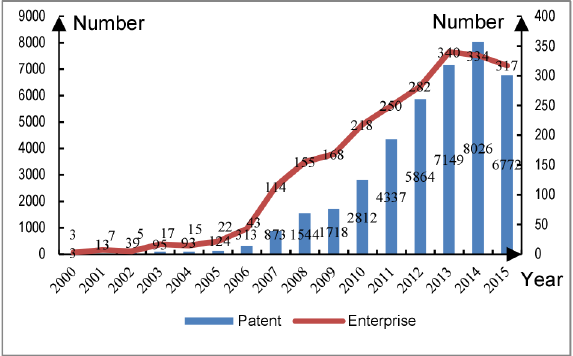
Figure 2. The number of applied patents and enterprises from 2000 to 2015